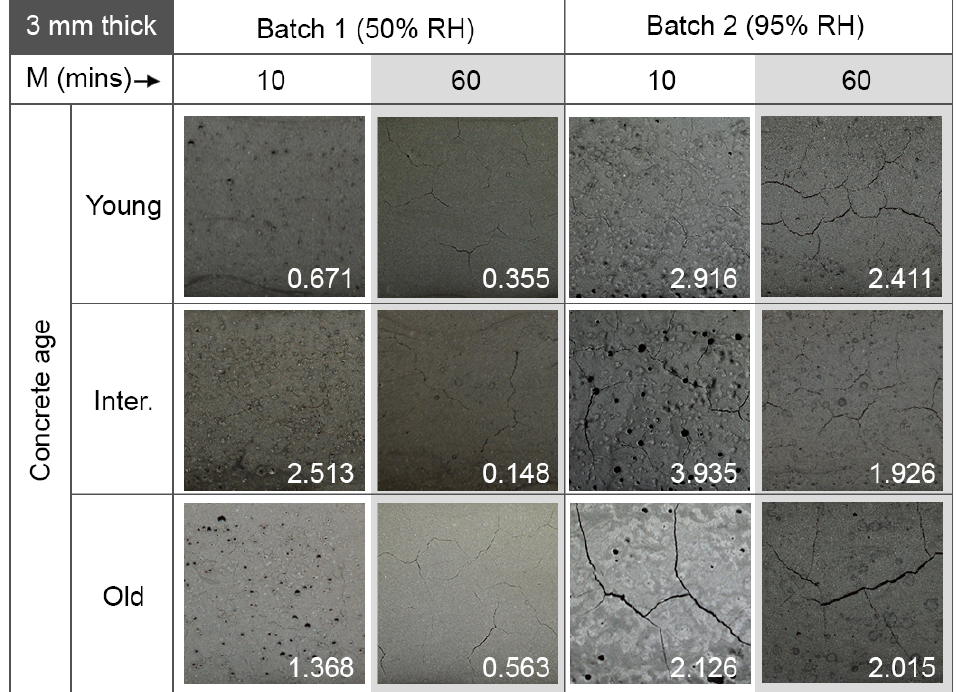
Figure 9. Images of 3 mm thick geopolymer coatings on concrete. Results are shown as a function of geopolymer mixing time, M; relative humidity during curing; and concrete substrate age. All images shown cover a 40 mm × 40 mm area on the sample. The numbers shown inset in each image are the crack percentages generated by the quantification algorithm.